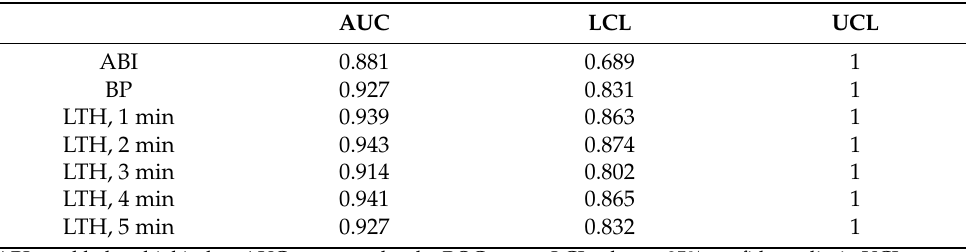
Table 3. Area under the ROC curve showing the diagnostic potential of IOFF and ABI for identifica- tion legs with a critical decrease in TcPO 2 (<20